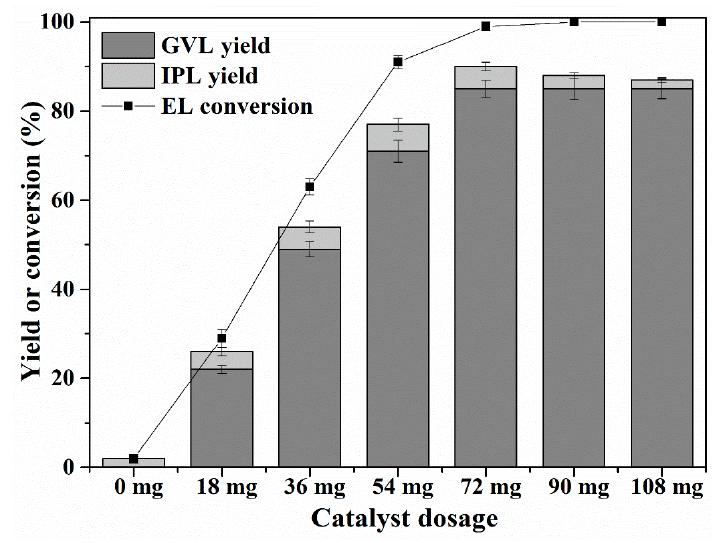
Figure 9. Effect of catalyst dosage on the conversion of EL to GVL. Reaction conditions: EL, 1 mmol; 2-propanol, 5 mL; T, 160 °C; and t , 6 h. Table 2. Activity comparison of various solid catalysts in the conversion of EL to GVL a .